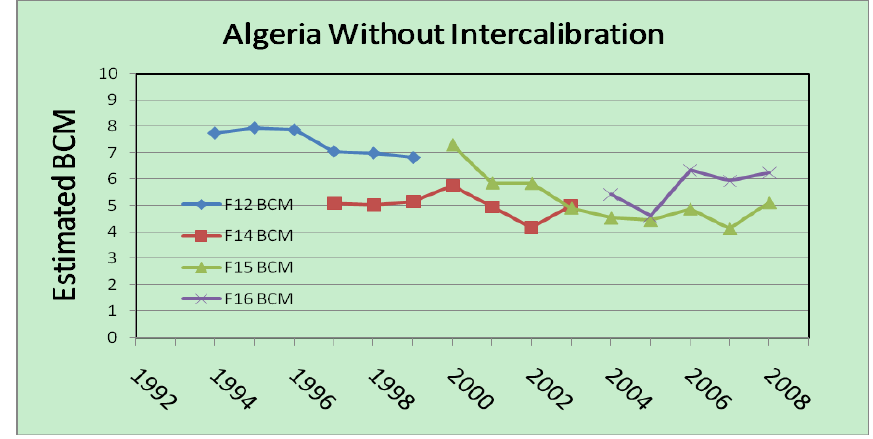
Figure 5. Estimation of gas flaring of Algeria with and without intercalibration of the different